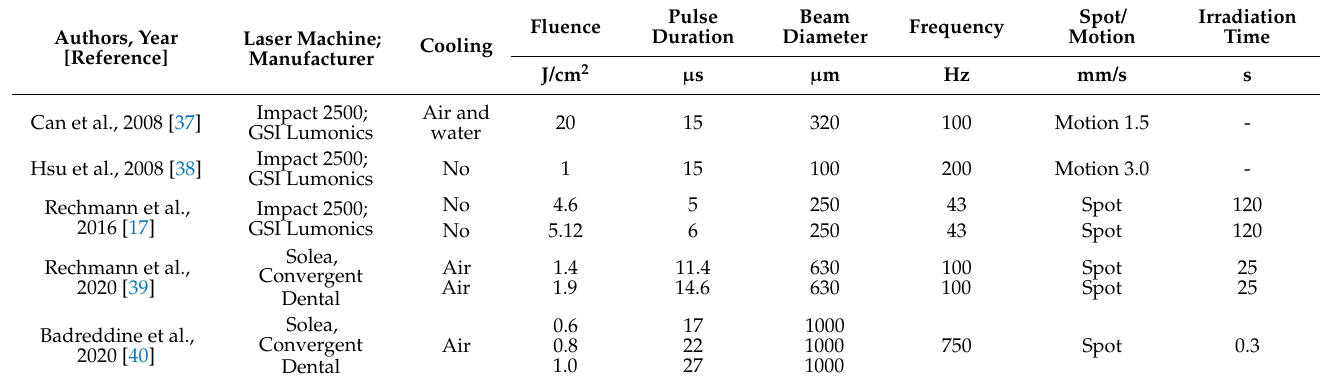
Table 1. Parameters for the 9300 nm carbon dioxide laser used in the studies of the systematic review.